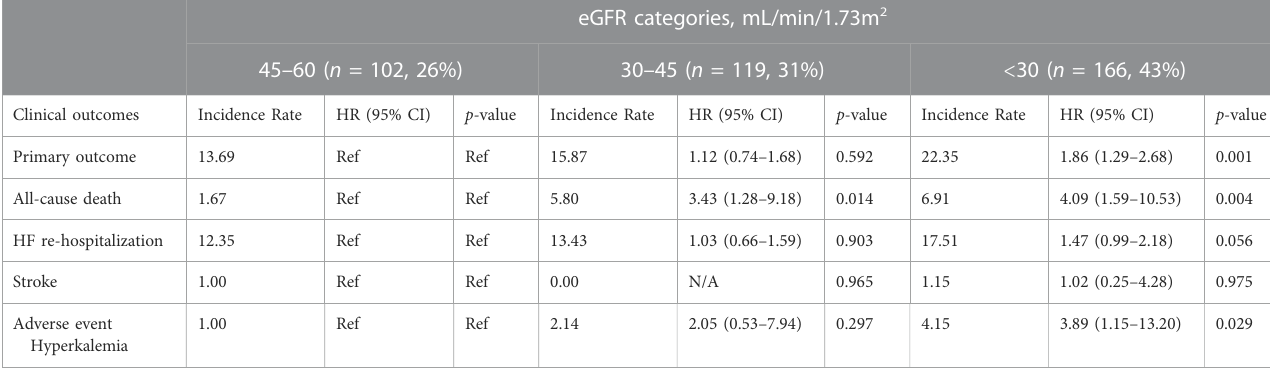
TABLE 6 Incidence rates and hazard ratios for cardiovascular outcomes by eGFR